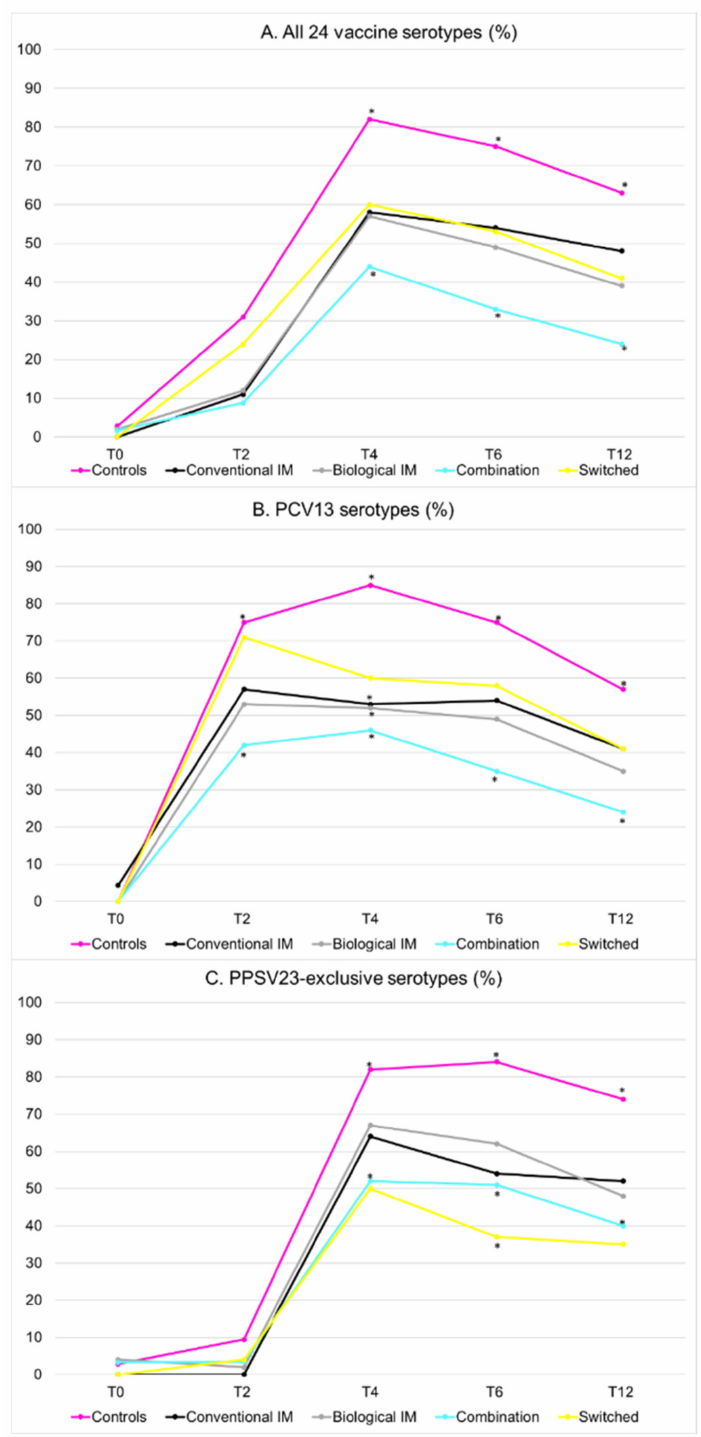
Figure 3. ( A ) Seroprotection rates over time for all 24 vaccine serotypes; ( B ) Seroprotection rates over time for serotypes included in PCV13; ( C ) Seroprotection rates over time for serotypes exclusive to PPSV23. IM = immunomodulator. T = time point in months from enrollment. * Highlights seroprotection rates that differ significantly from the other groups at that time